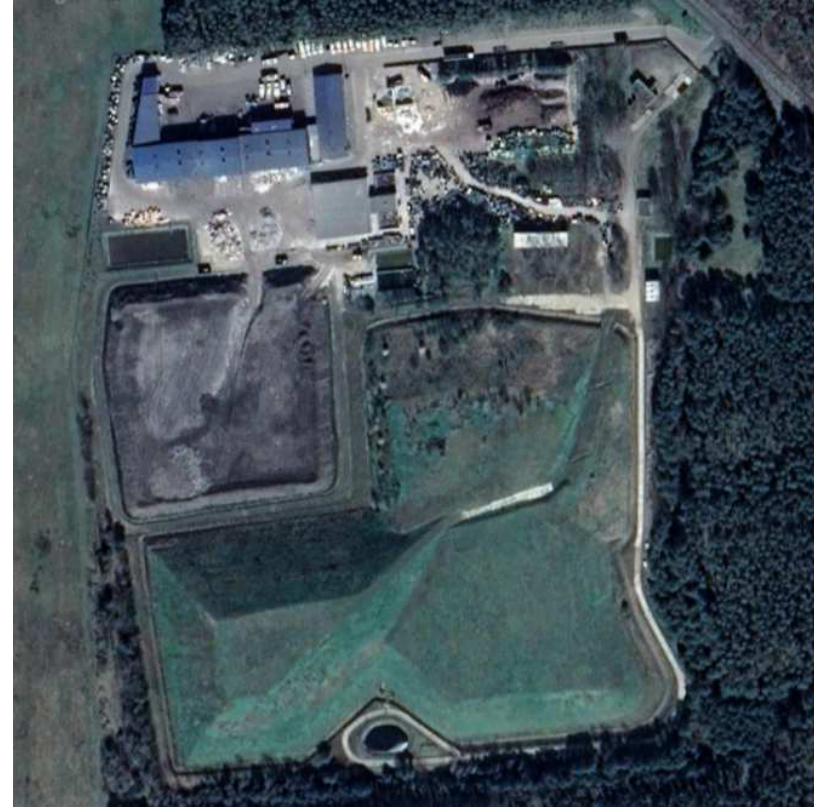
Figure 1. Reclaimed municipal waste landfill in Kiełcz. The test stand where the landfill gas was burnt is shown in Figure 2.